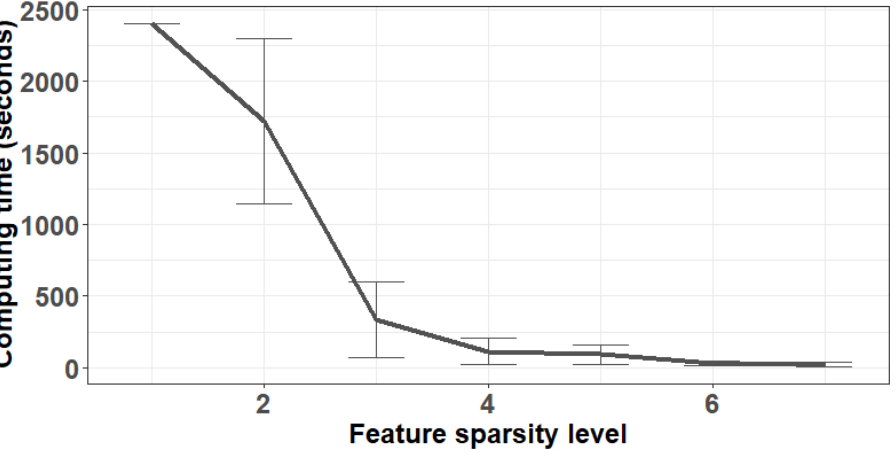
Figure 1. Average computing times across various feature sparsity levels k p in simulated data following the data generation approach described above with n = 50, p = 7, p 0 = 4, and k n = 5. Bars represent ± 1 standard deviations over 5 simulation